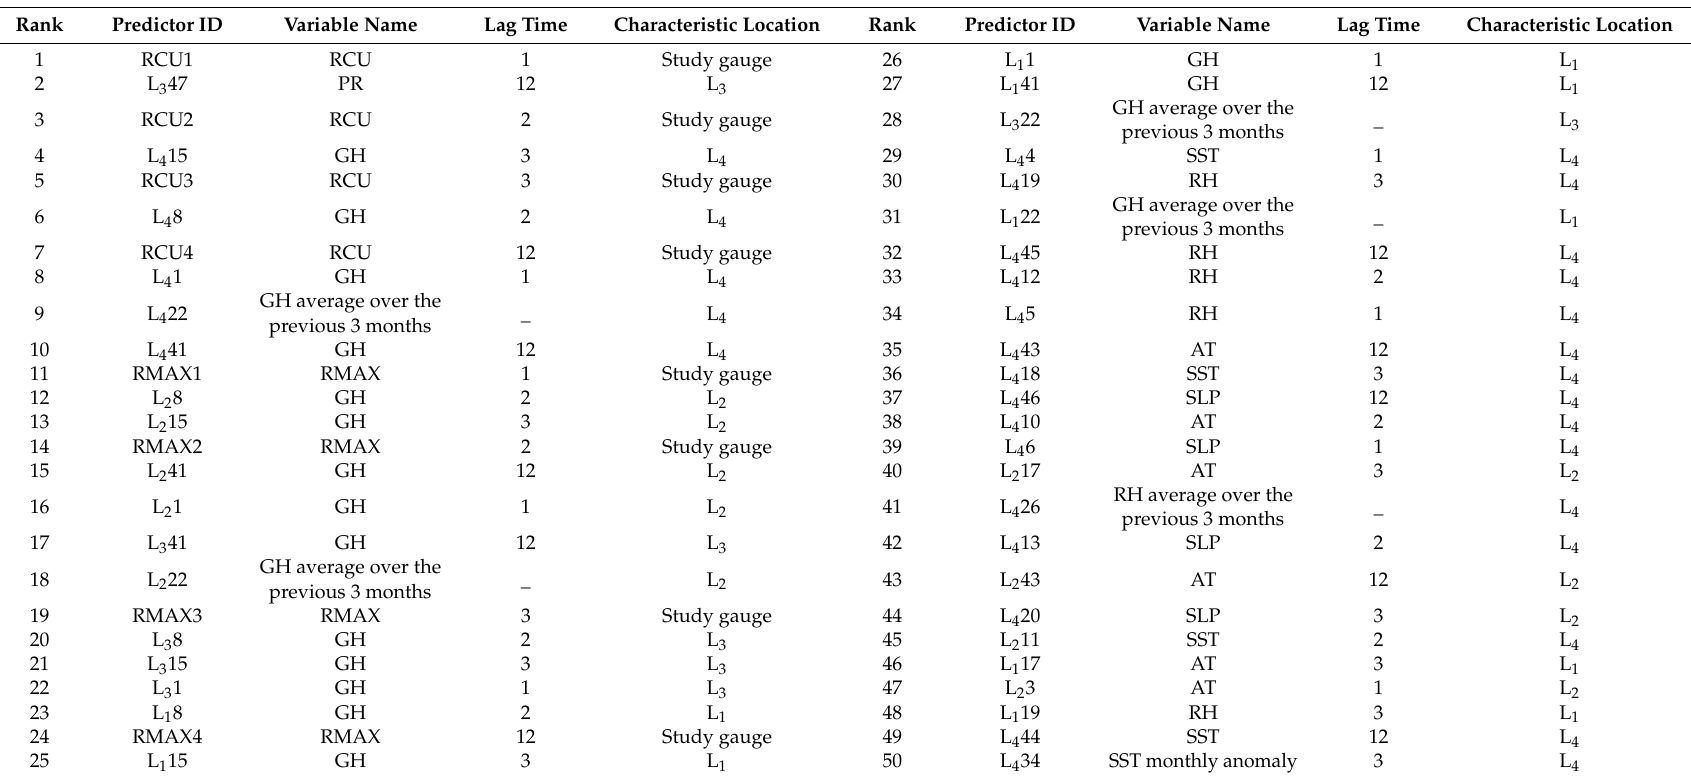
Table 5. Rank and list of the most effective predictors for forecasting RCU selected based on MRMR